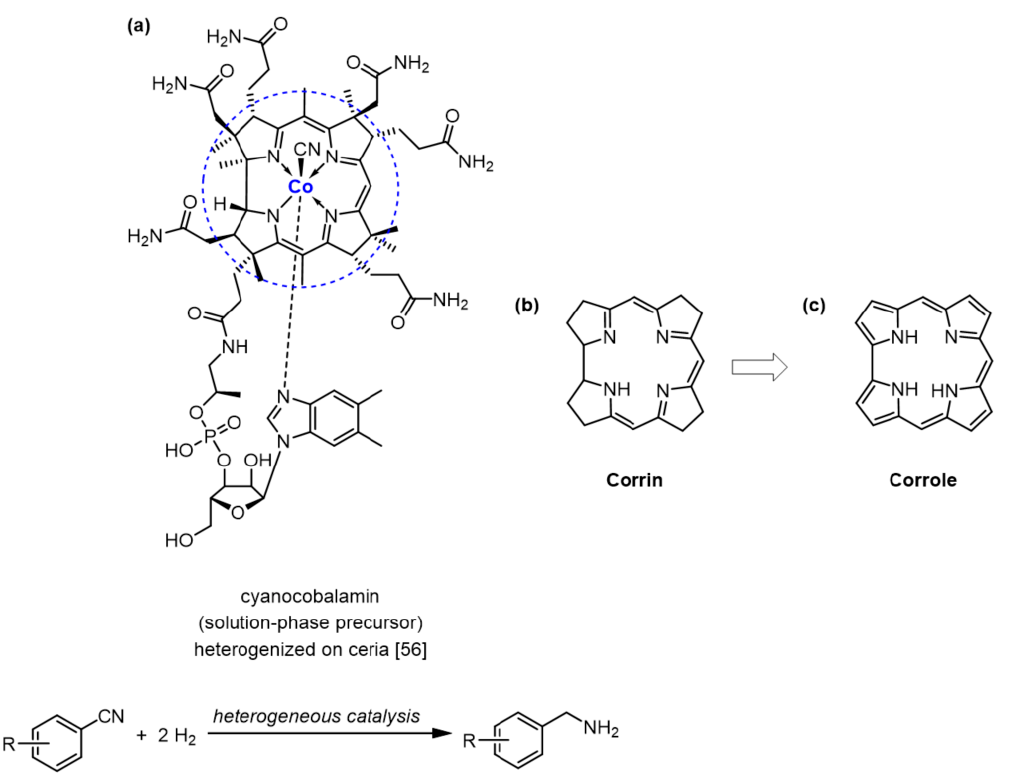
Figure 1. ( a ) Naturally occurring vitamin B 12 (cyanocobalamin) has previously been applied as a precursor compound for the preparation of a solid ceria-supported catalyst that facilitated the pressure hydrogenation of benzonitrile derivatives. ( b ) Structural drawing of the corrin base frame upon which vitamin B 12 and kindred bioactive macrocyclic metal complexes are built upon. ( c ) Molecular structure of the corrole scaffold that herein serves as the key motif for the design of a carbonaceous N -doped heterogeneous hydrogenation catalyst based on cobalt.